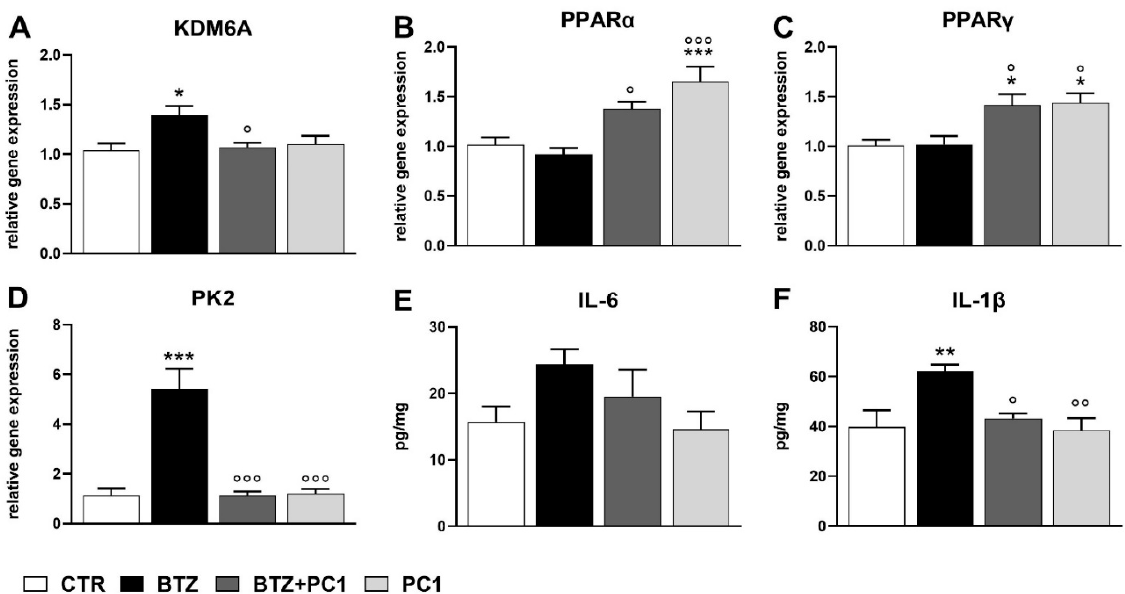
Figure 3. Spinal cord biochemical alterations assessed at the day 28 after BTZ treatment (0.4 mg/kg, 3 times/week for 4 weeks) and effect of PC1. PC1 (150 µ g/kg s.c., twice daily) was administered alone or together with BTZ for 14 days, starting from day 14 until day 28. ( A – D ) mRNA levels determined by qPCR for KDM6A, PPAR α , PPAR γ , and PK2. ( E , F ) protein levels determined by ELISA for IL-6 and IL-1 β . Data are expressed as mean ± SEM of six mice/group (* p < 0.05; ** p < 0.01; *** p < 0.001 vs. CTR; ° p < 0.05; °° p < 0.01; °°° p < 0.001 vs. BTZ; analyzed by one-way ANOVA followed by Bonferroni’s multiple comparison test).